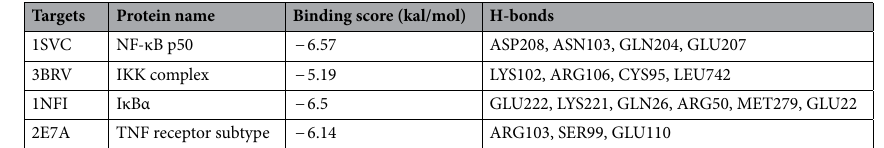
Table 10. Binding score (kcal/mol) of quercetin and targets of inflammatory